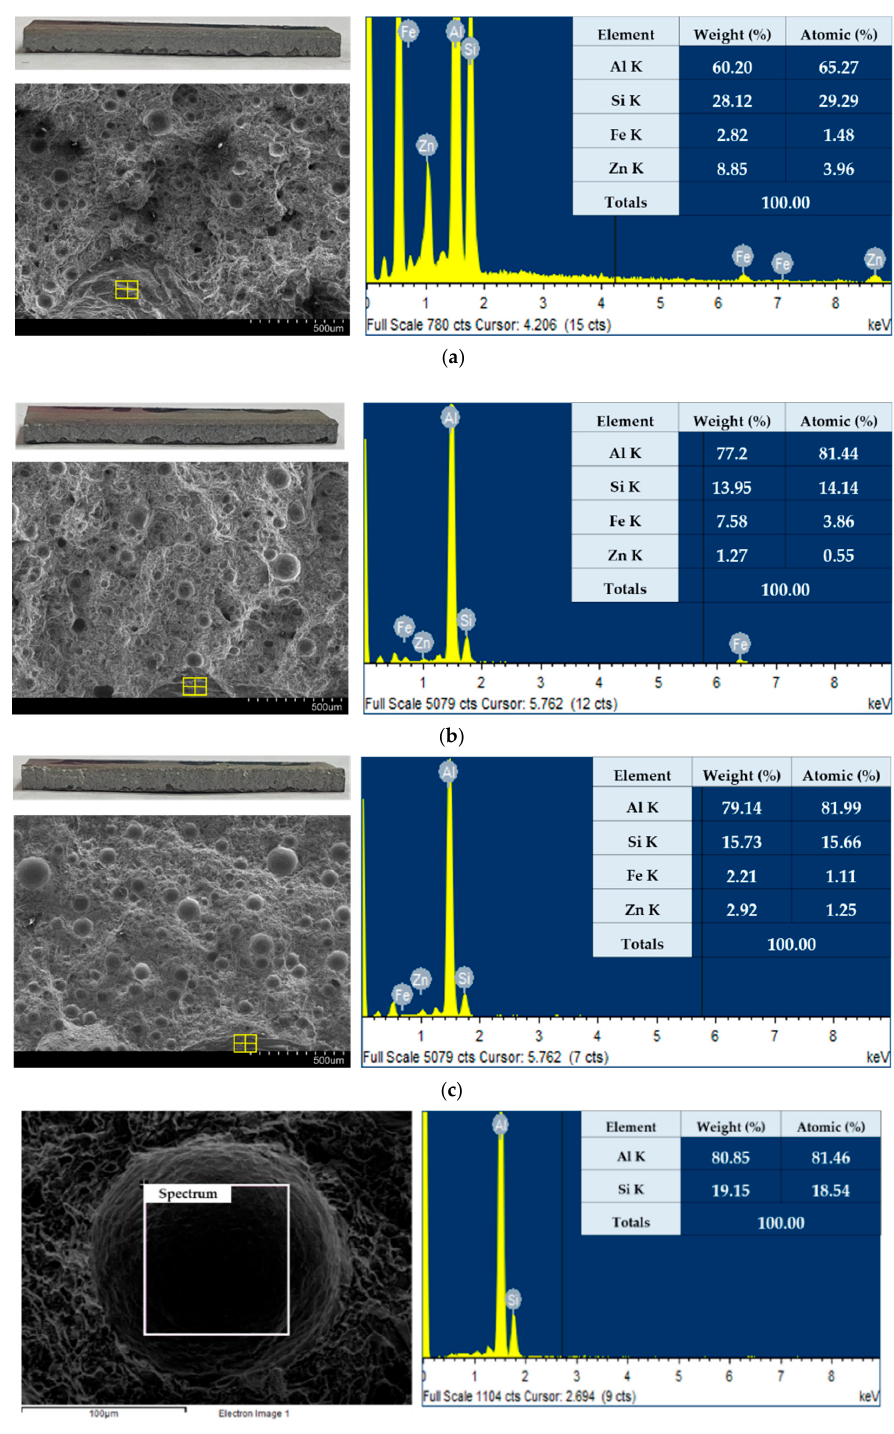
Figure 7. SEM-EDS spectrum measured in root area: ( a ) 0%, ( b ) 10%, ( c ) 20% and ( d ) magnified view of ( c ) on pores.